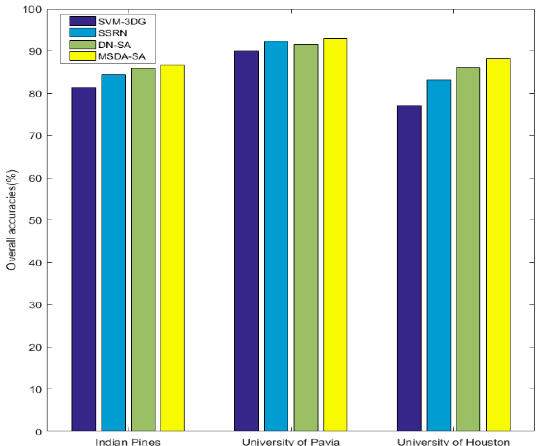
Figure 12. Effect of dilated convolution on: Indian Pines, University of Pavia and University of Houston datasets .